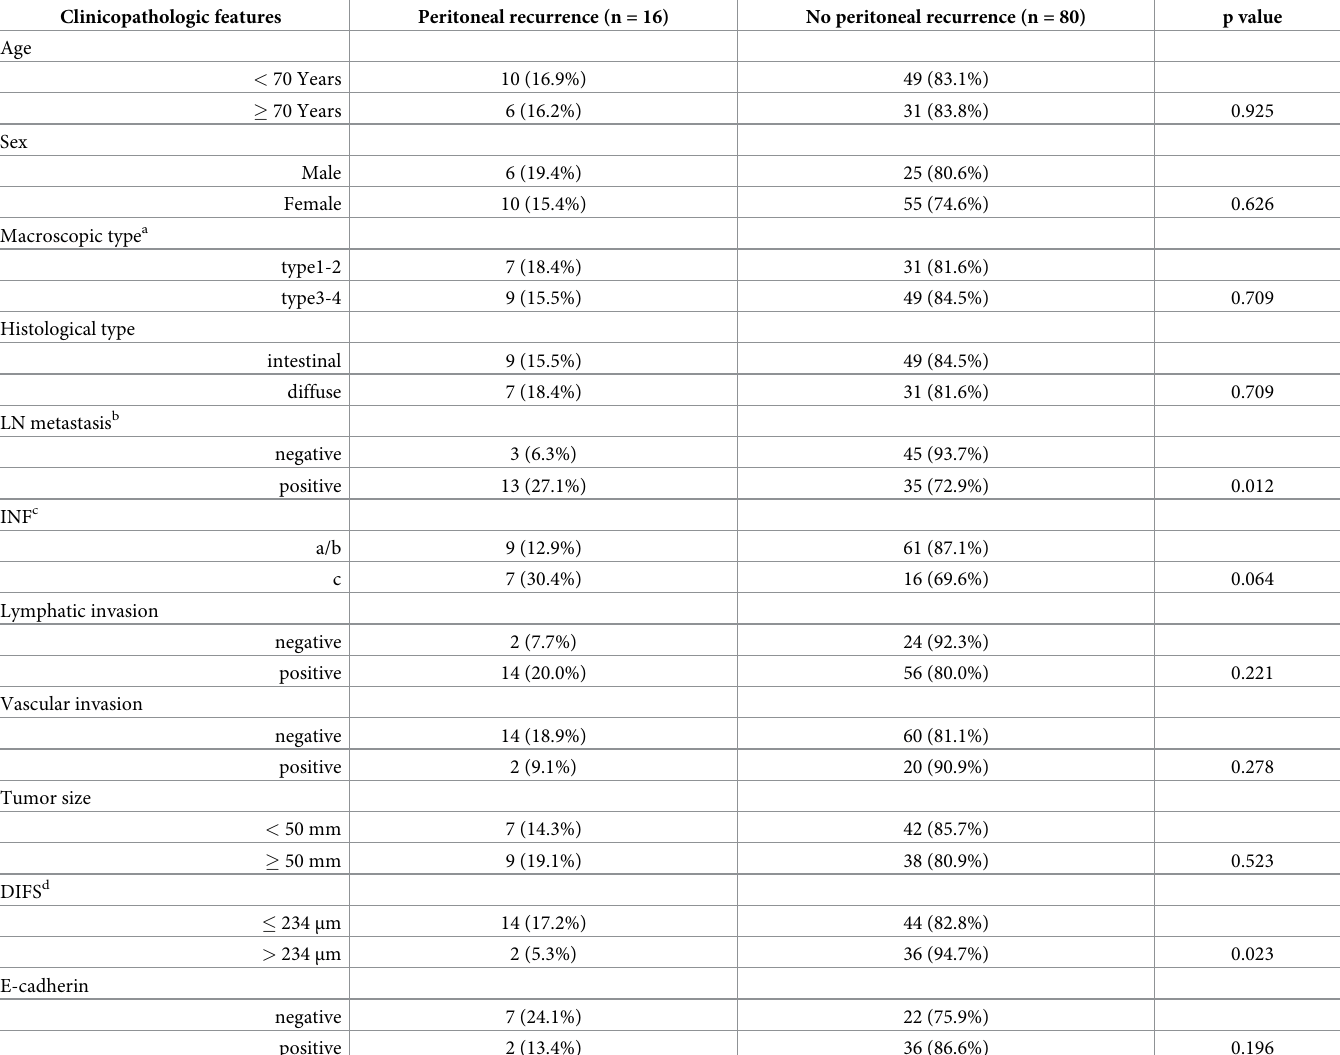
Table 1. Correlation between peritoneal recurrence and clinicopathologic features in 96 cases at T3 stage. Clinicopathologic